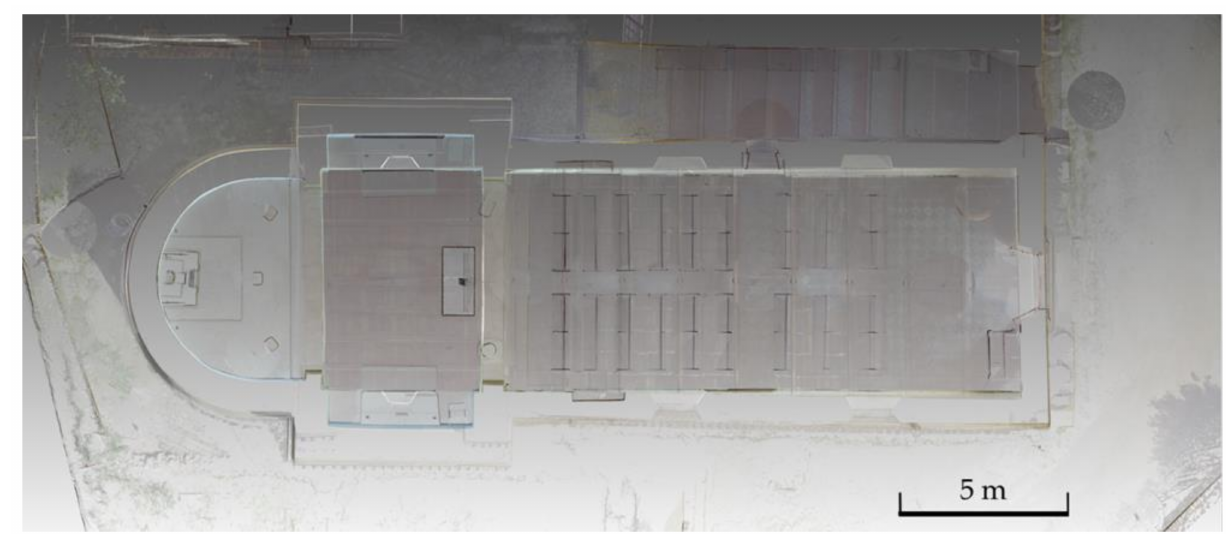
Figure 10. The resulting multi-layer plan, year